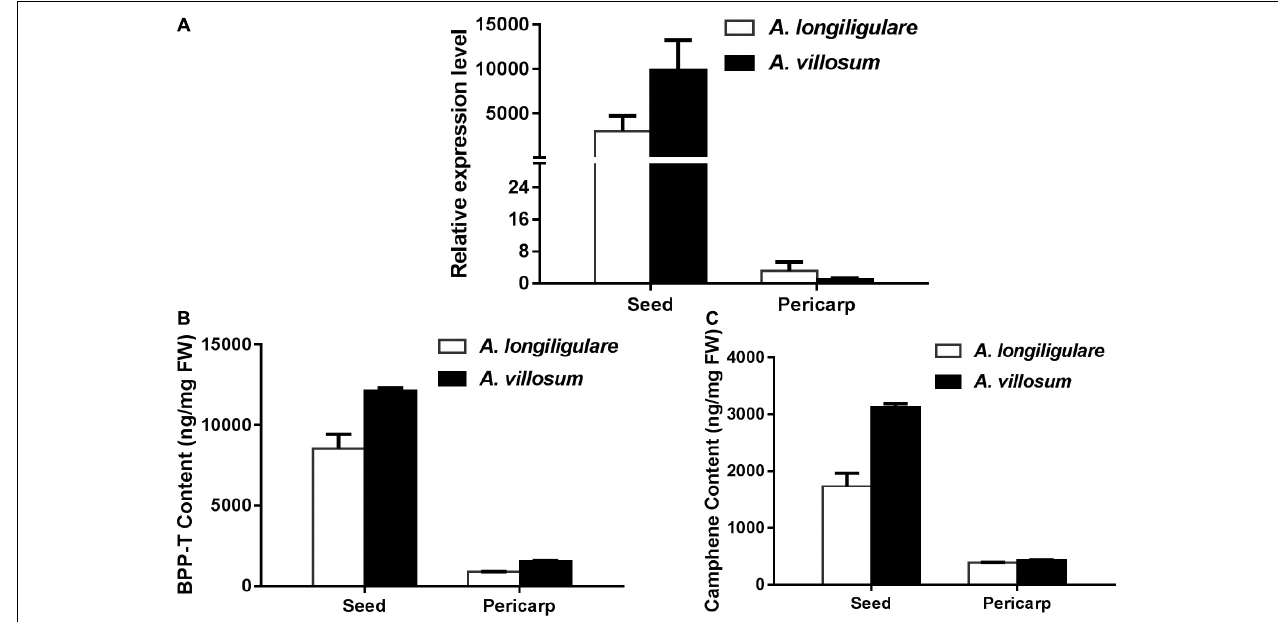
FIGURE 8 | Expression levels of AlTPS3 and AvBPPS and related monoterpenoids in fruits of A. longiligulare and A. villosum . (A) The expression levels of AlTPS3 and AvBPPS . (B) The total content of BPP-related terpenoids. BPP-T means BPP-related terpenoids (borneol, camphor and bornyl acetate). (C) The content of